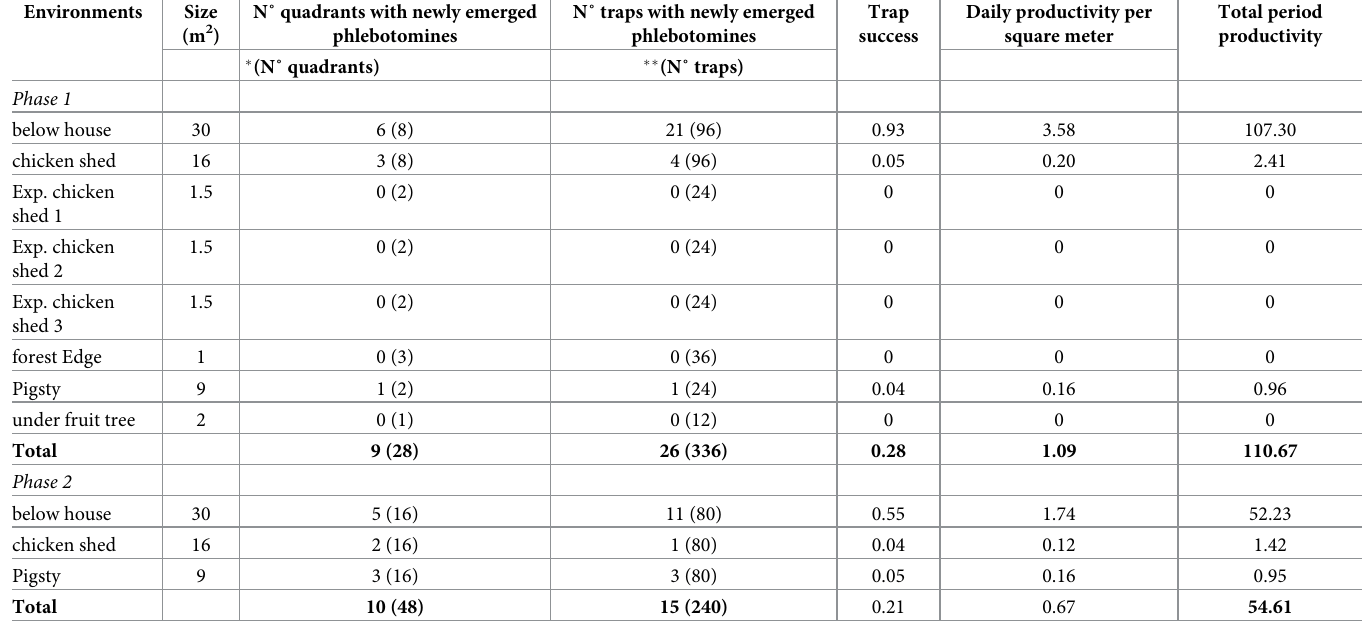
Table 2. First collection period . Summary of the newly emerged phlebotomines captured in domestic and peridomestic environments during the first collection period: phase 1 (from March 16 th , 2014 to March 26 th , 2015–379 nights-12 cycles) and phase 2 (from March 26 th , 2015 to October 7 th , 2015–195 nights-5 cycles), in a farm located in the “Dos Mil Hecta´reas” area, south of Puerto Iguazu´ city. Size of each environment (Size, m 2 ), Number of quadrants with newly emerged phlebotomines (number of soil quadrants sampled in each environment where at least one phlebotomine emerged), Number of traps with newly emerged phlebotomines (total number of traps set in each environment where at least one phlebotomine emerged), Trap success (number of newly emerged phlebotomines/number of traps), daily productivity of each envi- ronment (number of emergent phlebotomine/m 2 /day) and total period productivity (number of newly emerged phlebotomines in the total area of each environment on each farm for the entire collection